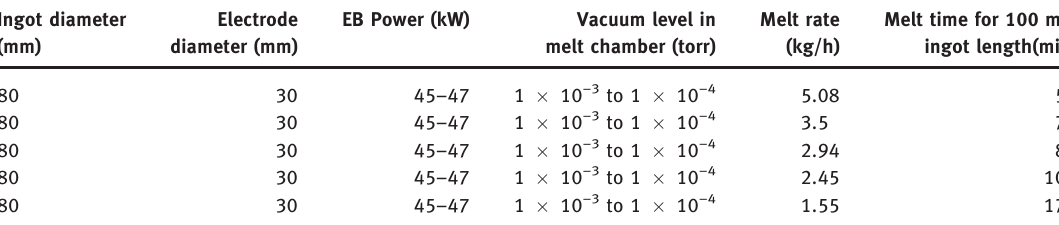
Table 1: EBM process parameters for 80 mm diameter ingot. Ingot diameter (mm)